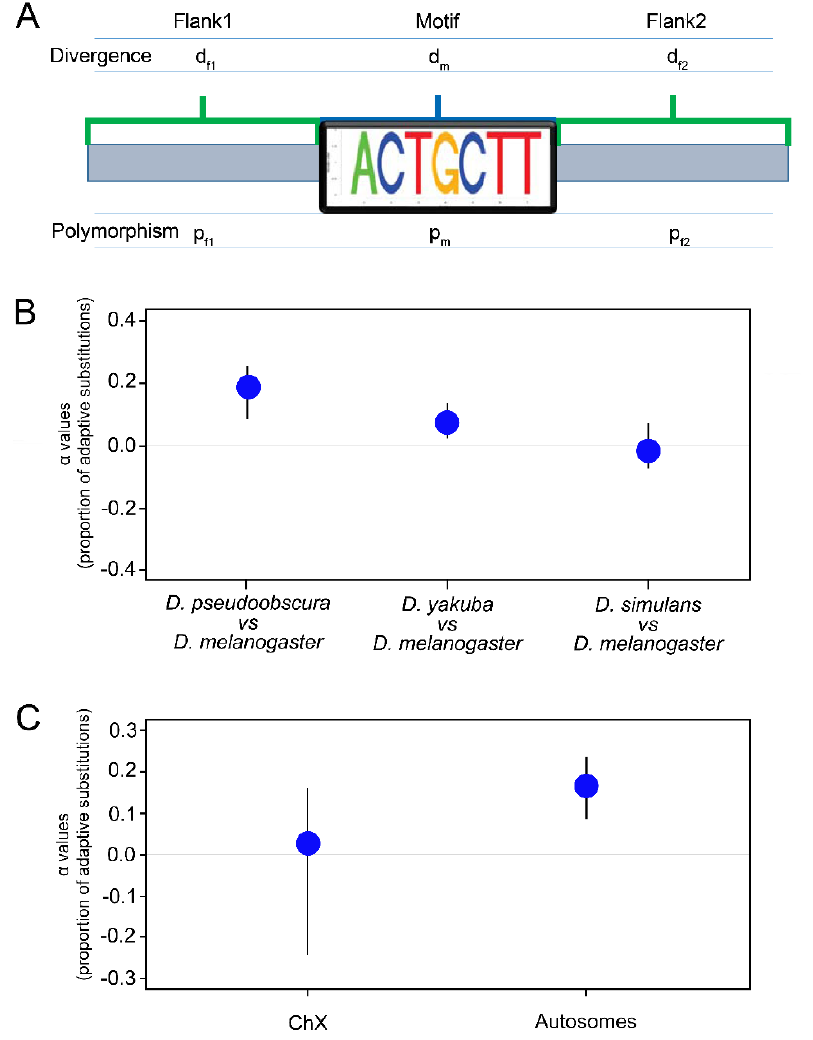
Figure 4. CAZAM exhibits a signature of selection. ( A ) Schematic illustrating our modification of the McDonald–Kreitman test. We substitute central and flanking sites for dN and dS, respectively, allowing us to measure selection on all identified instances of the motif. ( B ) Plot depicting observed α ( α ) values (interpreted as the proportion of adaptive substitutions) for different comparisons, with bootstrapped 99% confidence intervals. Motifs located and mapped from D. pseudoobscura and D. yakuba show values of α significantly different from zero, while motifs from D. simulans do not. ( C ) Comparison of estimated α values from motifs which map to the X chromosome (left) in contrast to those which map to the autosomes (right). Values of α are significantly lower—indicative of weaker selection—for motifs located on the X chromosome.